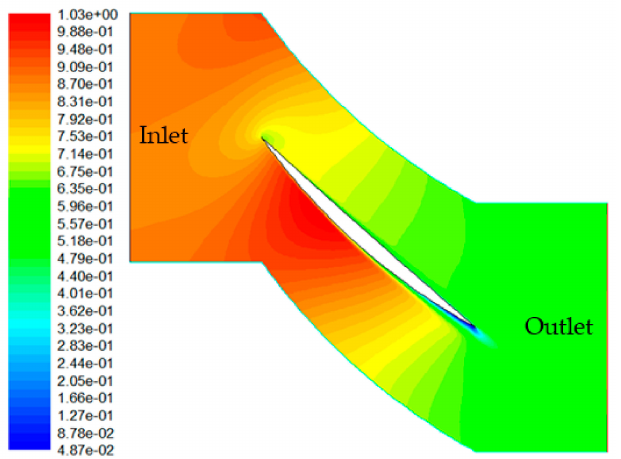
Figure 2. Structured grids on the numerical domain of a blade cascade.